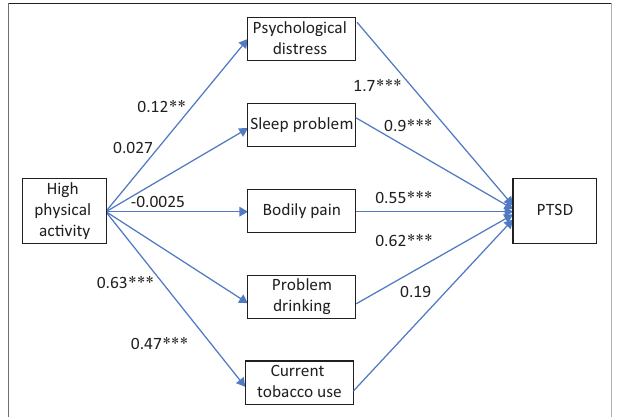
FIGURE 1: Generalised structural equation model legend: Total trauma events – high physical activity – post-traumatic stress disorder.